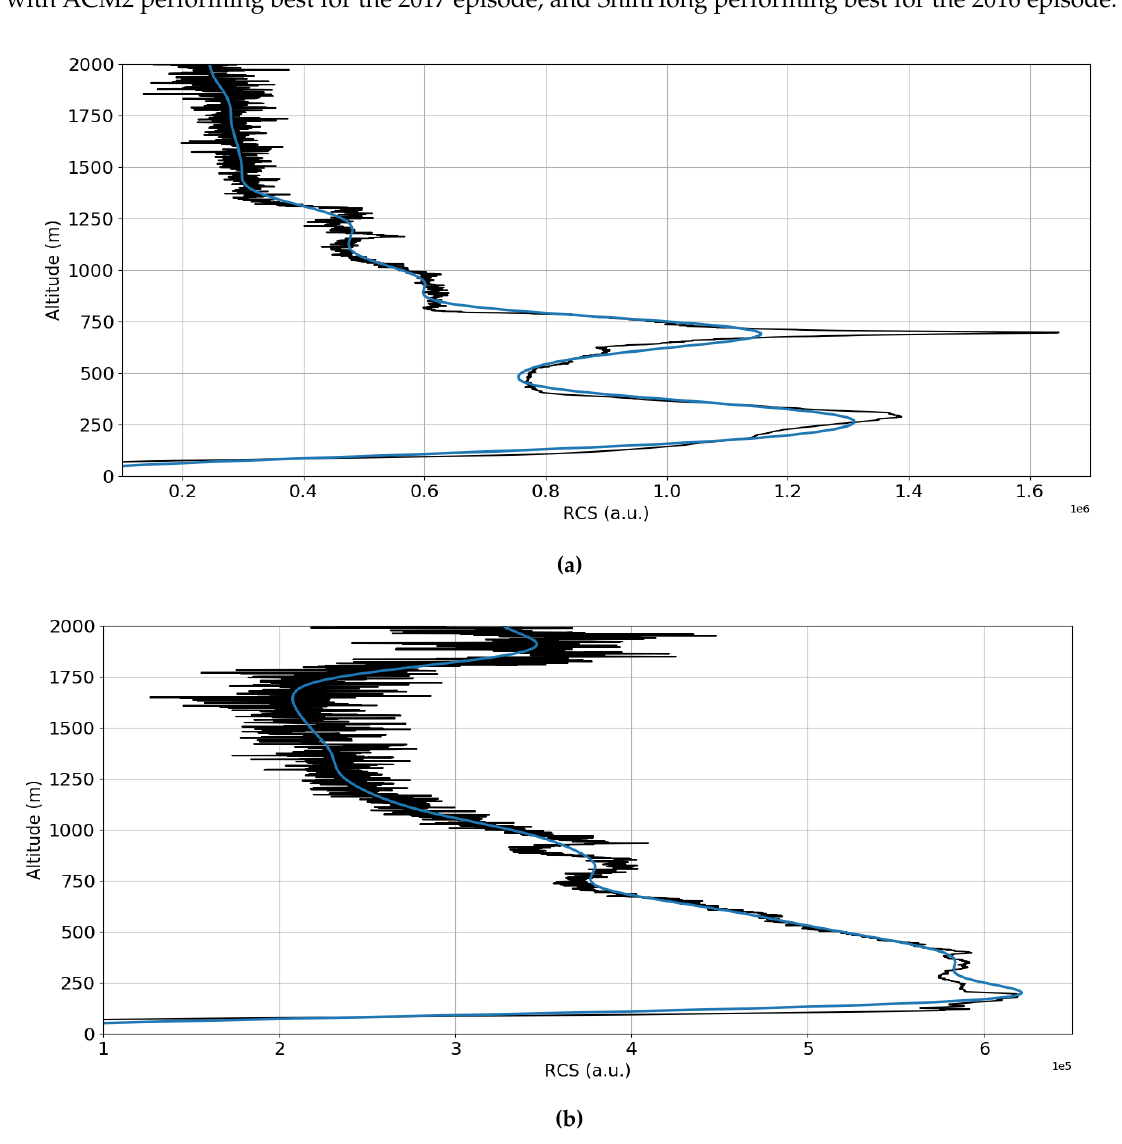
Figure 7. ( a ) Lidar-obtained RCS profile, 17 / 05 / 2017, 08:00 UTC, black: real data, blue: Savitsky–Golay Figure 7 . (a ) Lidar-obtained RCS profile, 17/05/2017, 08:00 UTC, black: real data, blue: Savitsky – smoothing of real data. ( b ) Lidar-obtained RCS profile, 04 / 04 / 2016, 08:00 UTC, black: real data, blue: Golay smoothing of real data. ( b ) Lidar-obtained RCS profile, 04/04/2016, 08:00 UTC, black: real data, Savitsky–Golay smoothing of real blue: Savitsky – Golay smoothing of real data.